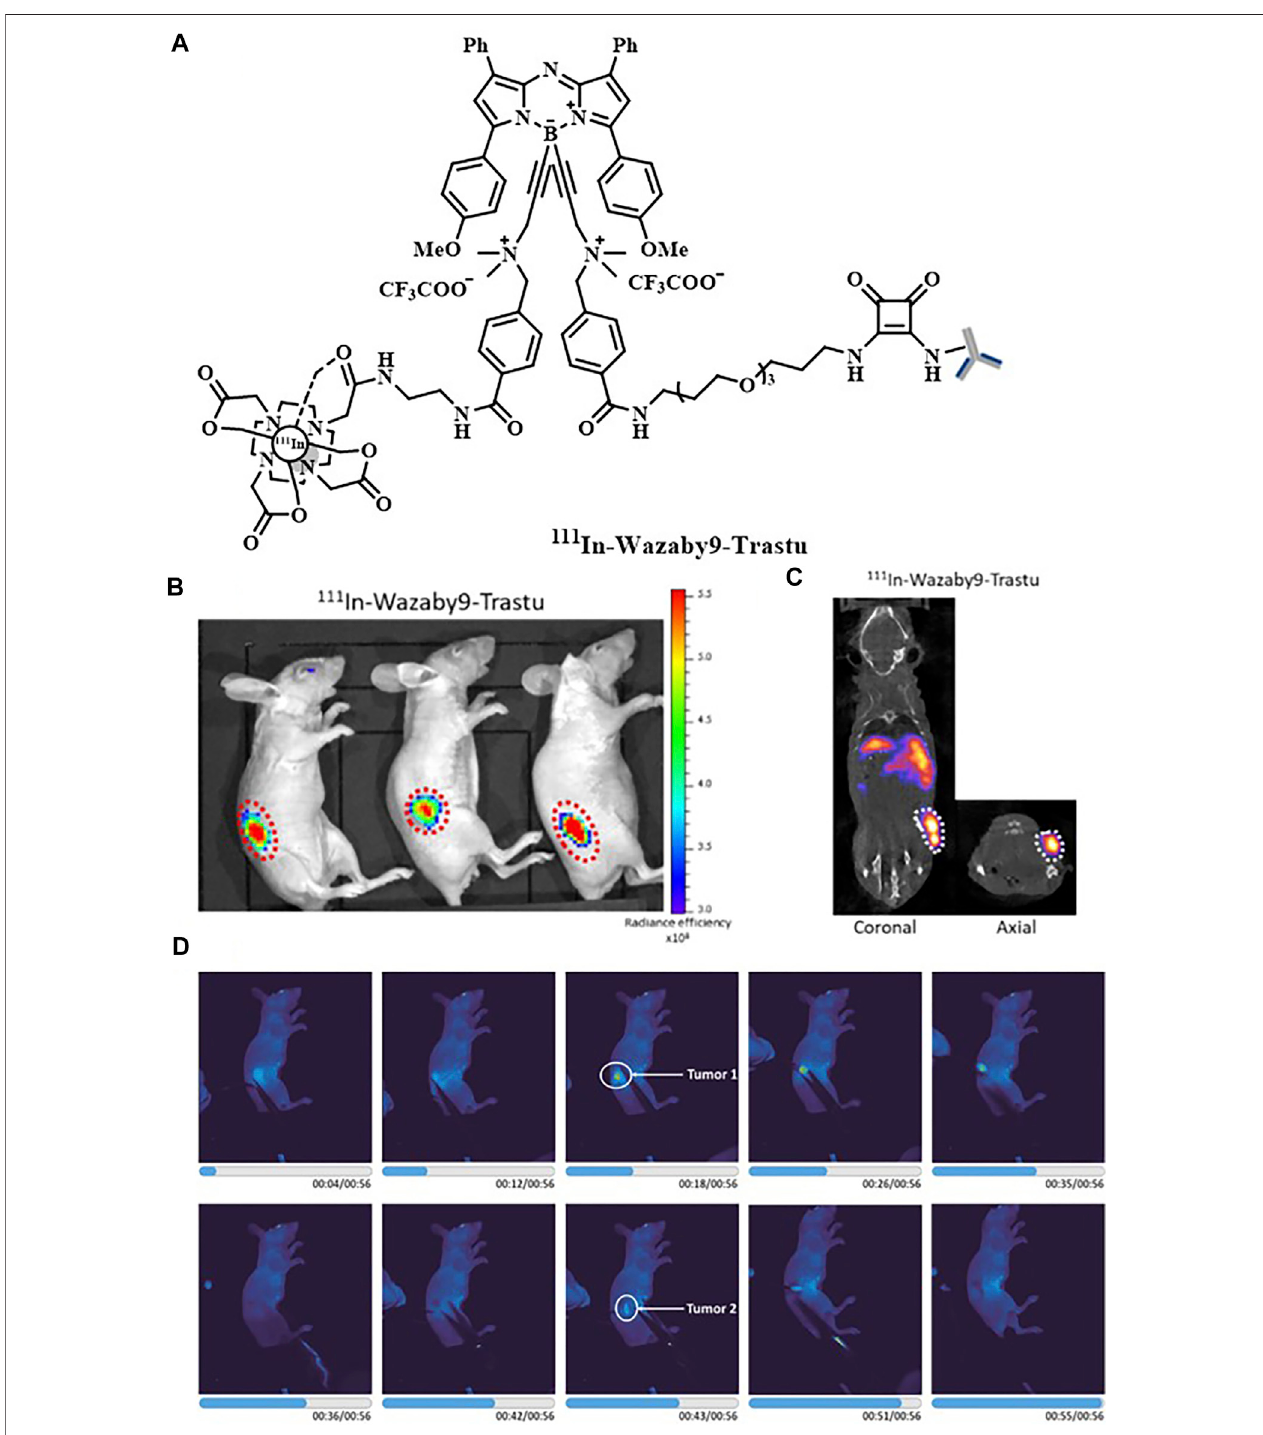
FIGURE 2 | (A) Structure of 111 In-Wazaby9-Trastu. (B) Near-infrared fl uorescence images of 111 In-Wazaby9-Trastu on mice bearing subcutaneous tumor of HCC1954 cells HER-2 + . (C) Representative SPECT/CT images. (D) Fluorescence-guided resection of tumor tissues. Reproduced with permission from Privat et al. (2021). Copyright 2021, American Chemical Society.